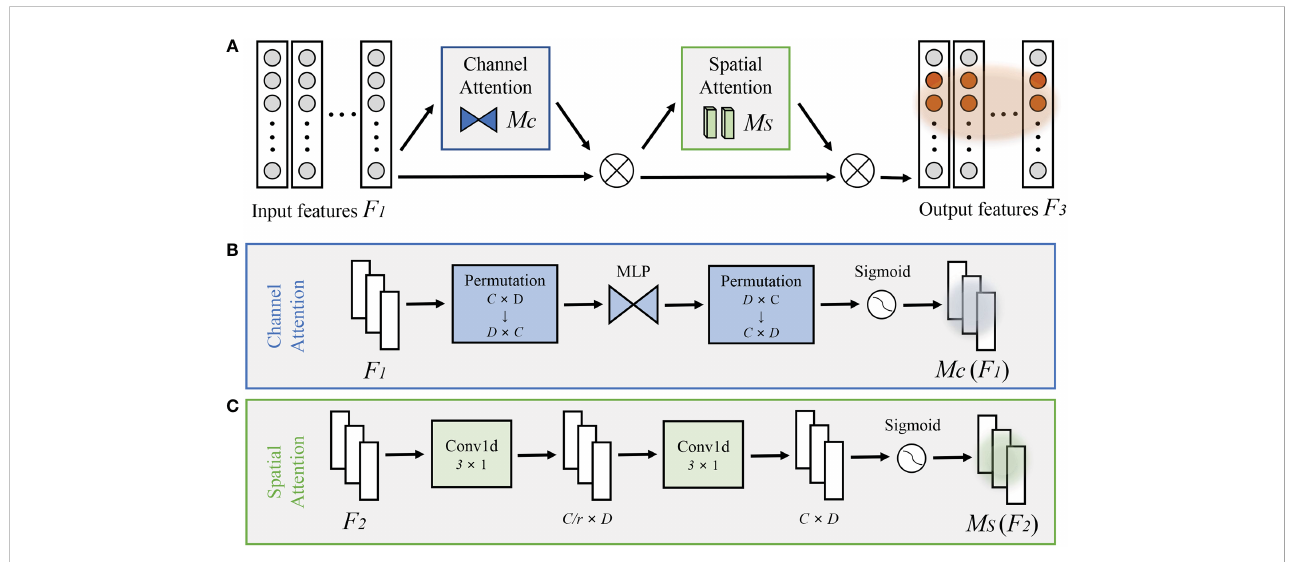
channel attention re fl ects the importance of different sources, while spatial attention re fl ects the model ’ s concentration on diverse physical depth levels. A major part of the channel attention submodule is shown in Figure 3B. When extracting information in two dimensions, 2D permutation is employed, and then a two-layer neuron network is used to magnify the dependence between channels and depth levels across dimensions. Each channel ’ s weights are then calculated using the sigmoid function. Figure 3C depicts the spatial attention submodule, which uses two convolutional layers to aggregate information from different depths and a sigmoid function to determine the weights of each depth.